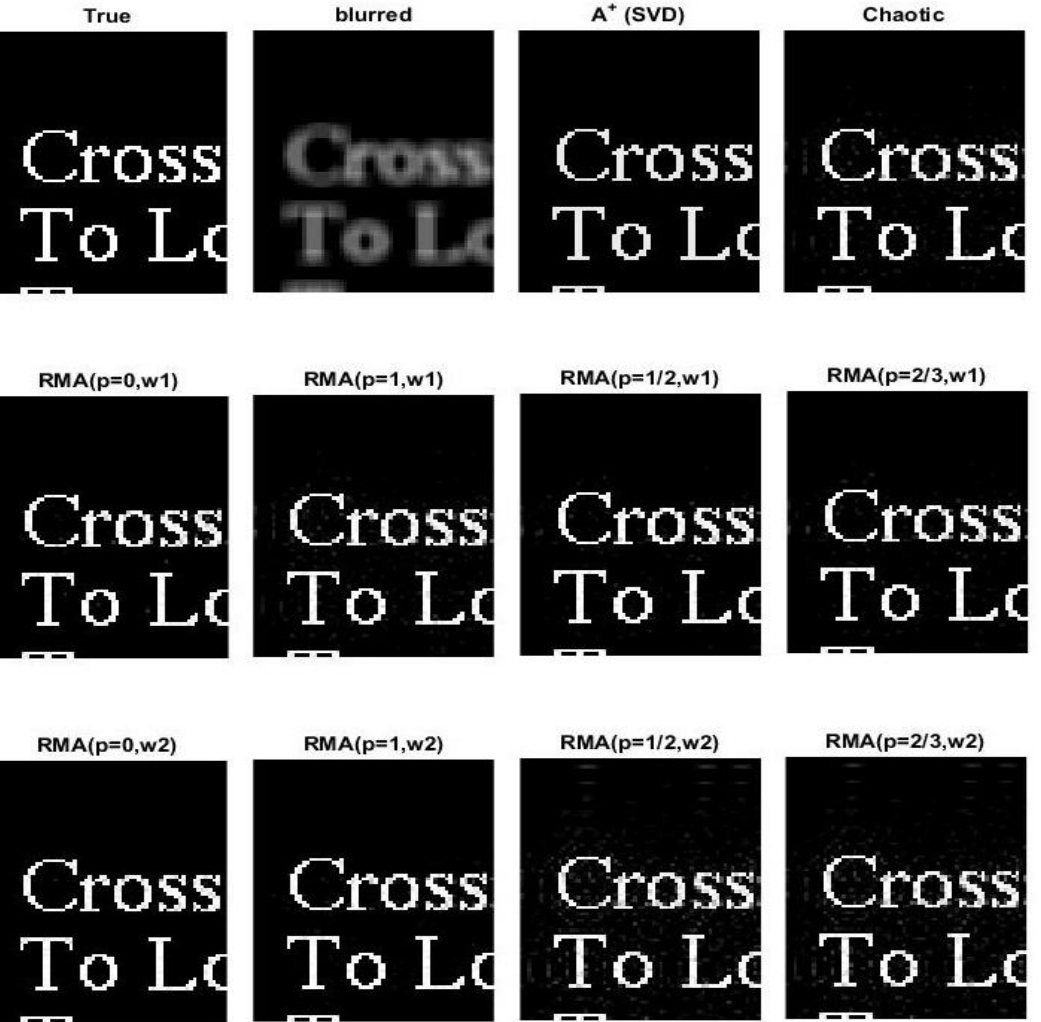
Figure 3. Deblurring results of the A + Bregman iteration, Chaotic iteration and RMA with ω 1 , ω 2 , when p = 0,1,1/2,2/3 for a 64 × 80 part of the sparse Words image convolved by a 5 × 5 Gaussian kernel and contaminated by a Gaussian white noise of σ 2 , σ = 10 .